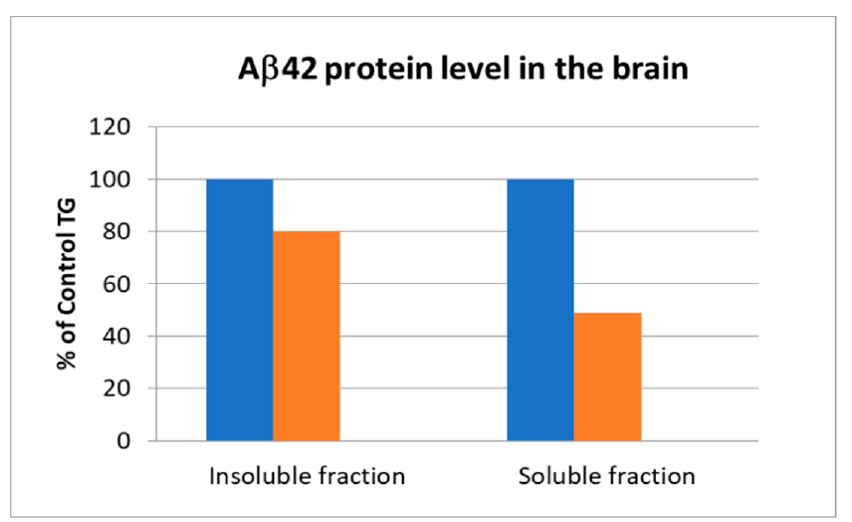
Figure 5. Decrease in A β 42 level in the brains of mice. In blue—control TG = transgene mice; In orange—tested compound, 2.